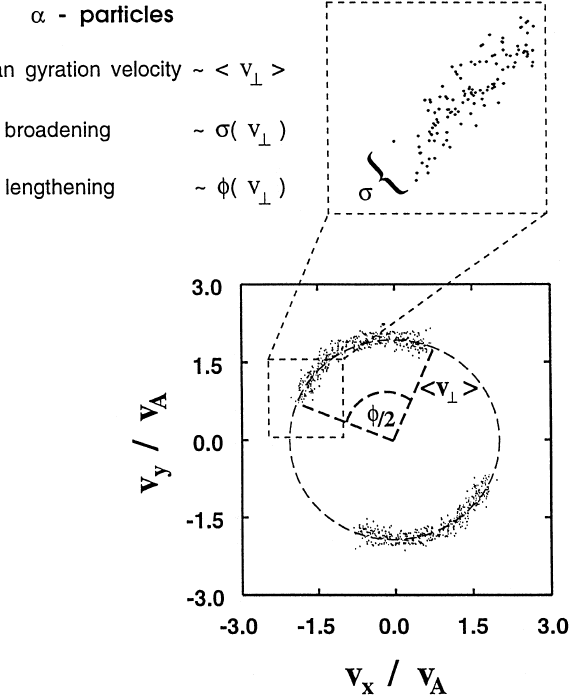
Fig. 6. Sketch of the di(cid:128)usion processes in